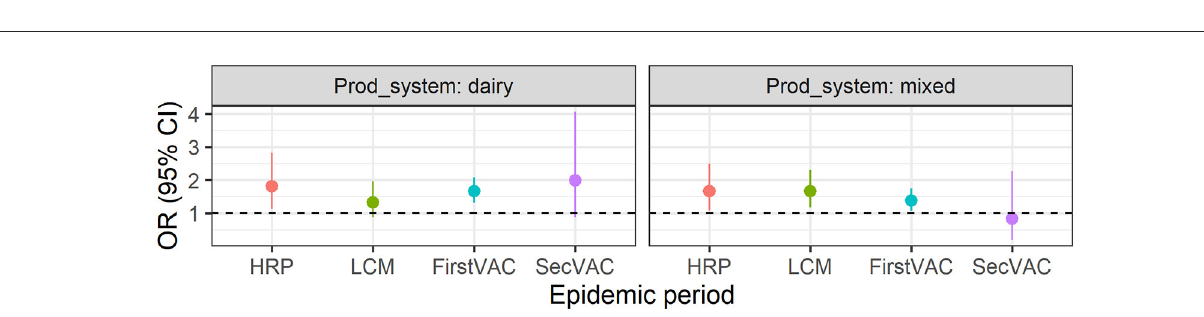
remained significant after controlling for other variables in the multivariable logistic regression model. During the HRP, the odds of being infected was 81% higher for dairy farms [OR = 1.81